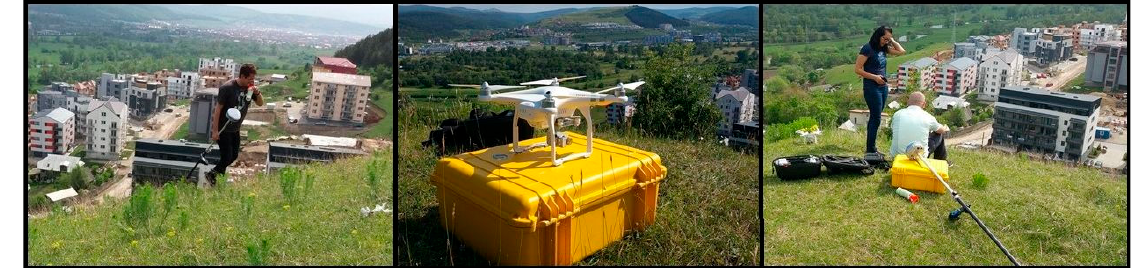
Figure 10. Ground control points (GCPs) and CPs GNSS RTK measurement and unmanned aerial vehicles (UAV) mis- sion preparations.